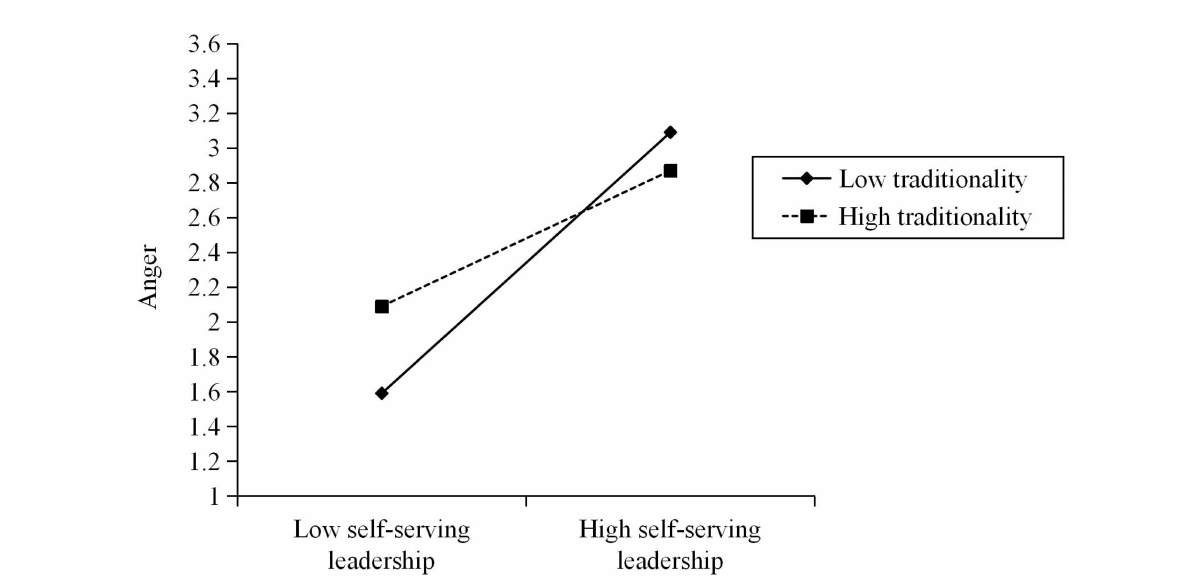
FIGURE 2 The moderating effect of traditionality on the relationship between self-serving leadership and anger.